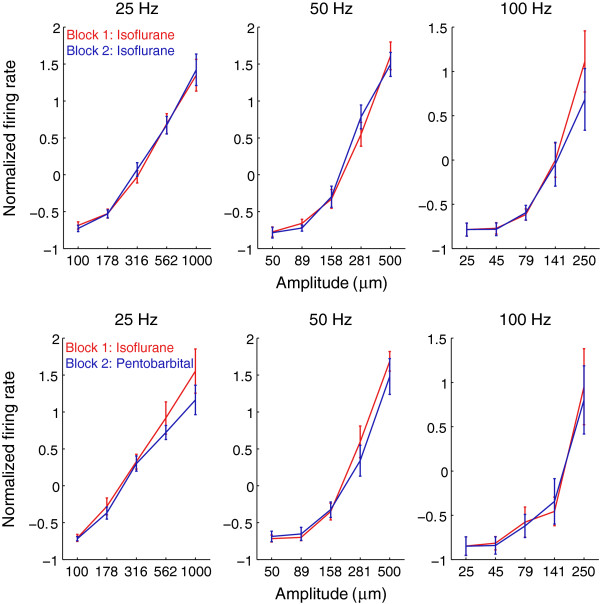
Effect of anesthesia on response strength over the population. Top: Normalized firing rates for the control group. Each point indicates the average normalized firing rate across single units of the same block under the same condition of stimulus. Error bars denote the standard error of the mean. Bottom: Normalized firing rates for the experimental group.